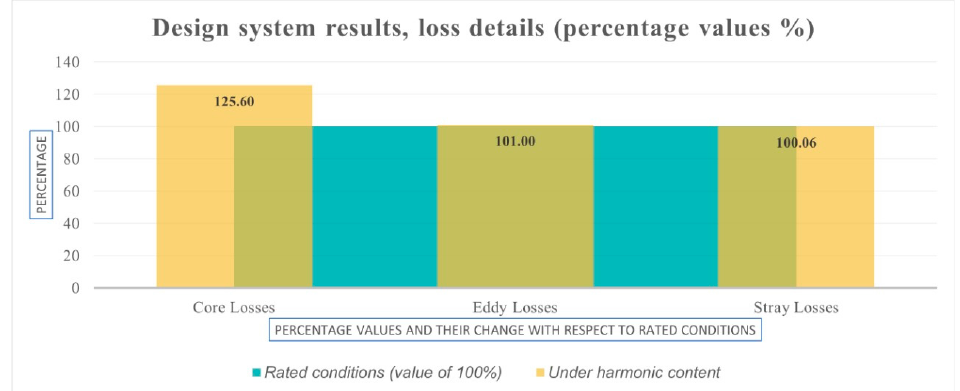
Figure 4. Percentage changes in losses between transformer standard design and harmonic profile design.